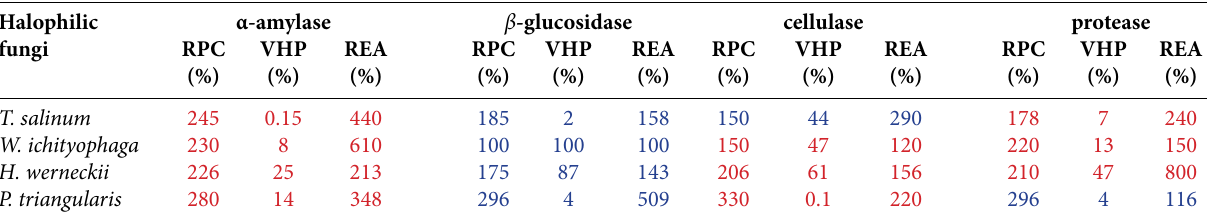
Table 6: Correlation between the viability of halophilic fungi, residual protein concentration and residual enzyme activity for selected enzymes (α-amylase, β -glucosidase, cellulase and protease) in the halophilic fungi cell suspensions. Halophilic α-amylase β -glucosidase cellulase protease fungi RPC VHP REA RPC VHP REA